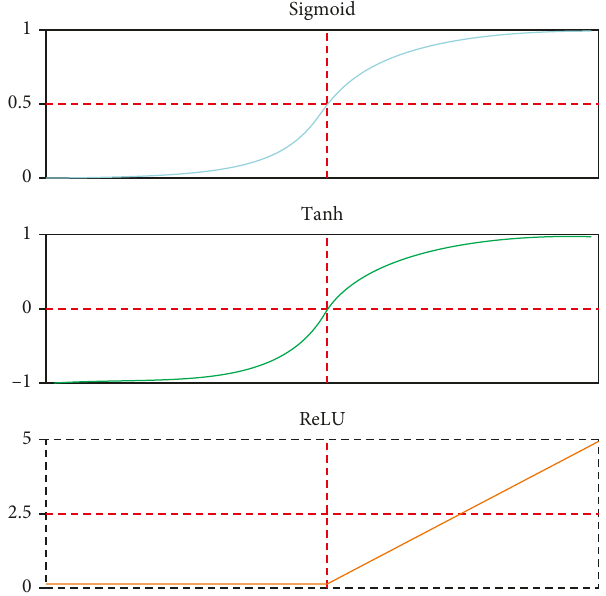
Figure 2: Schematic diagram of sigmoid function, tanh function, and ReLU